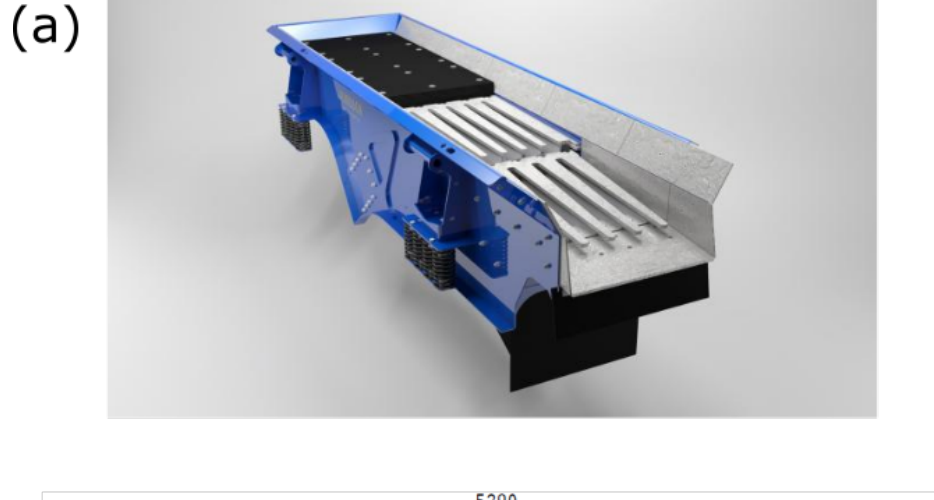
as well as tonnage going through the feeder, was used to ensure that the simulation was behaving similarly to reality. Two steel plates of Hardox 450 were observed for wear, see Figure 3. Before the installation of brand new steel plates, the tonnage and operational hours were observed. The steel plates were measured on 12 different positions on each wear plate by using an ultrasonic thickness gauge. The thickness gauge was of type KARL DEUTSCH ECHOMETER 1075 Basic, with an accuracy of ± 0.1 mm for plate thicknesses of 1.2–250 mm. Since both plates were measured, the total number of wear points was 24. A total of three separate measurement occasions were performed, excluding the initial thickness measurements of the plates. A template was made to make sure that identical positions on the plates were measured on every occasion.